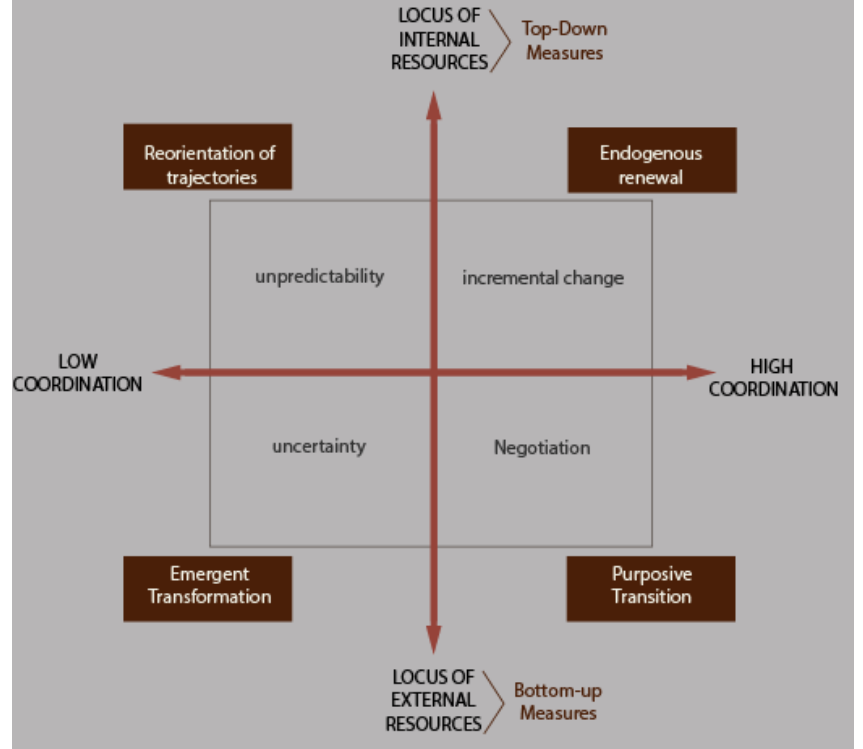
Figure 5. Transition contexts according to the degree of Coordination and the locus of the sources. Elaborated by the author based on Smith et al. [36].